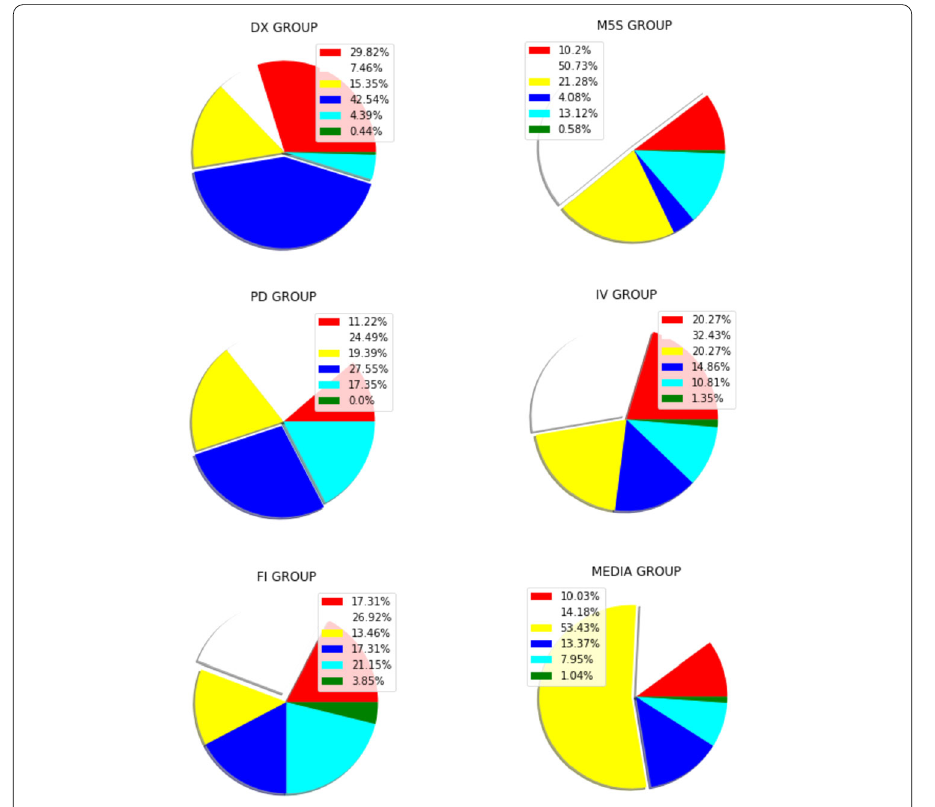
Figure 11 Inthegraphicstherearethenumbersoftimesahashtag,belongingtooneofthesemantic communitiesdescribedbefore,hasbeensharedbyaverifieduserofthediscursivecommunities